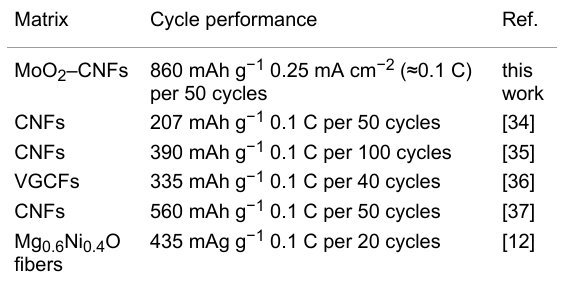
Table 3: Performance comparison of MoO 2 –CNFs with other matrices for application in Li–S batteries.